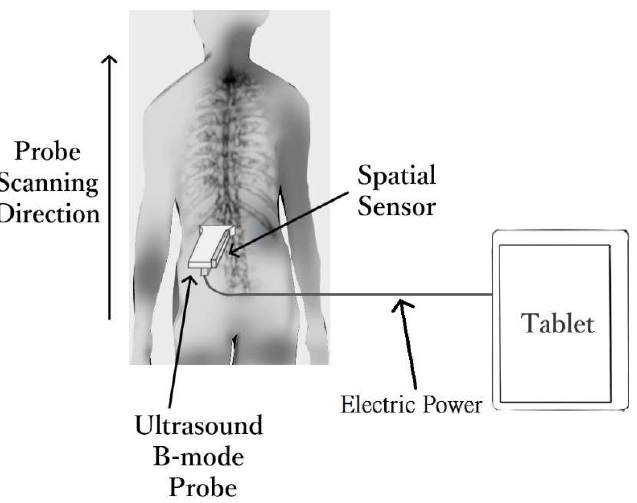
Figure 2. Technical diagram for the portable 3D ultrasound imaging system Scolioscan Air.